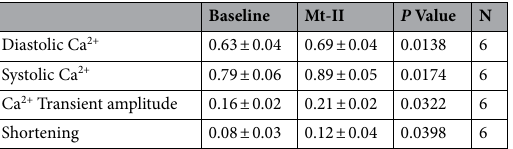
Table 2. Calcium transients and associated cell shortening in viable cardiomyocytes.